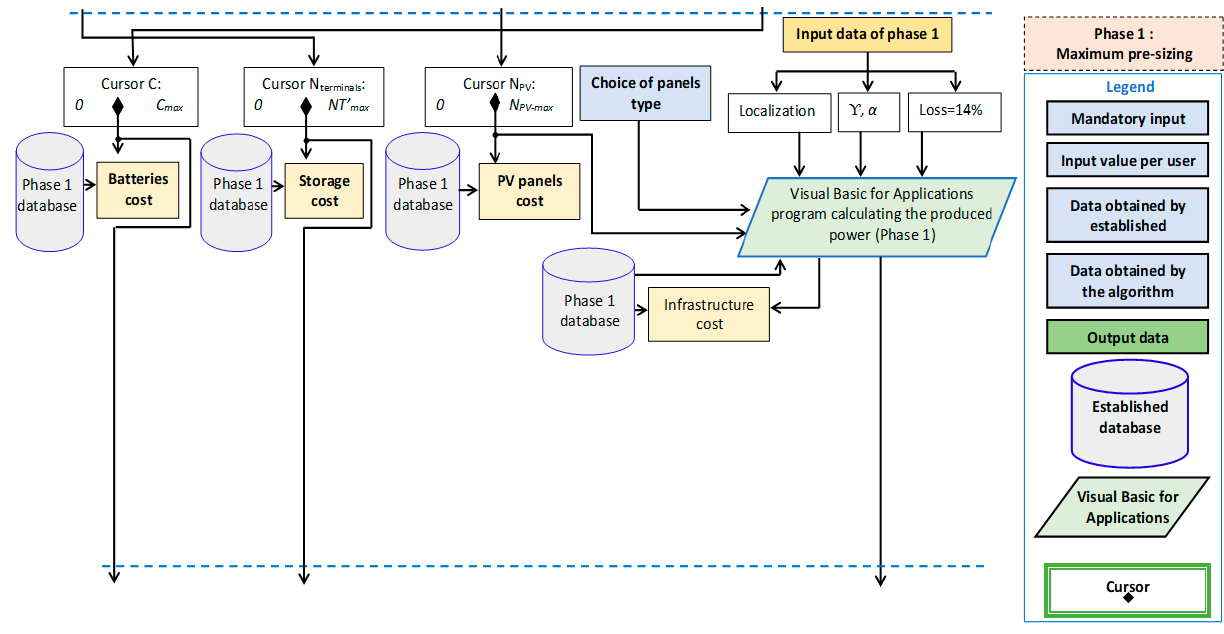
Figure 4. Flow chart of phase 2.